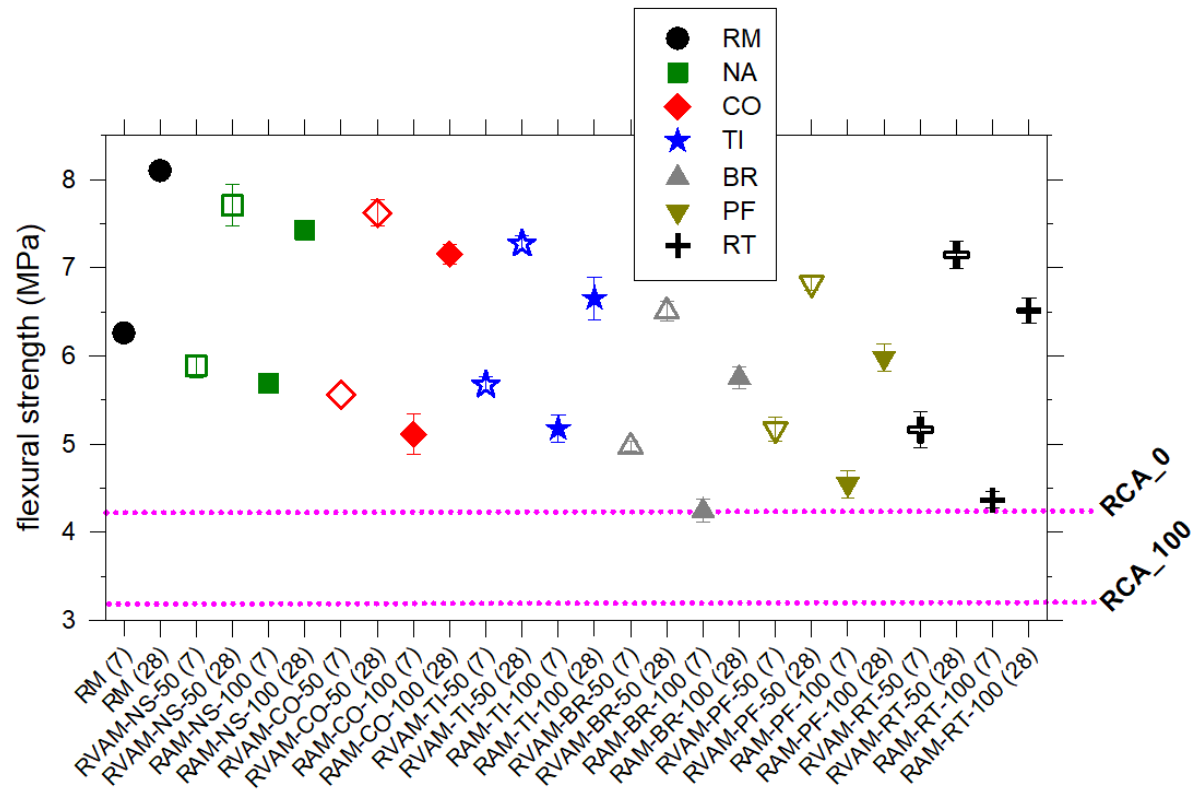
Figure 4. Variation of flexural strength of RM, RVAM and RAM. Unfilled symbols refer to RVAM and filled symbols refer to RAM. The horizontal pink lines correspond to the compressive strength RAC prepared with normal strength RCA and NA in the fraction of 0 and 100 wt.% (RCA_0) and entirely with RCA (RCA_100), as reported in [27] .